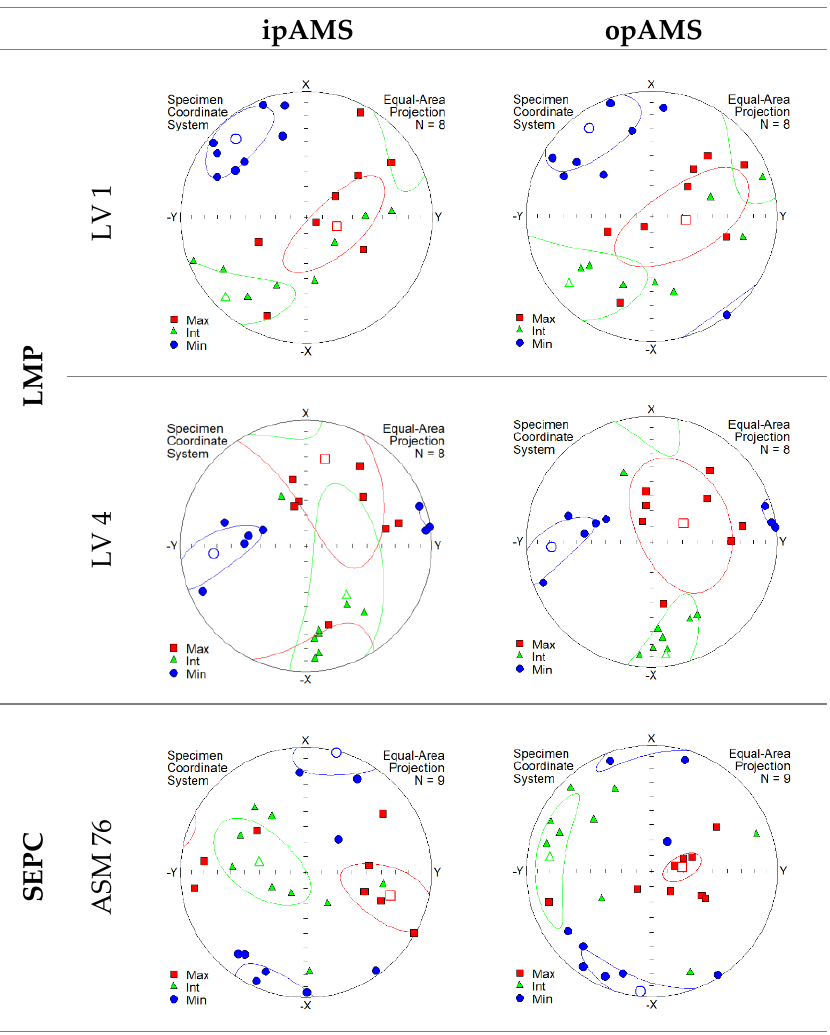
Figure 5. ipAMS and opAMS mean tensors for LMP and SEPC sub-samples, according to specimen coordinate system, and 95% confidence areas. Equal-area projection, lower hemisphere (the hollow symbols represents the corresponding mean vectors).